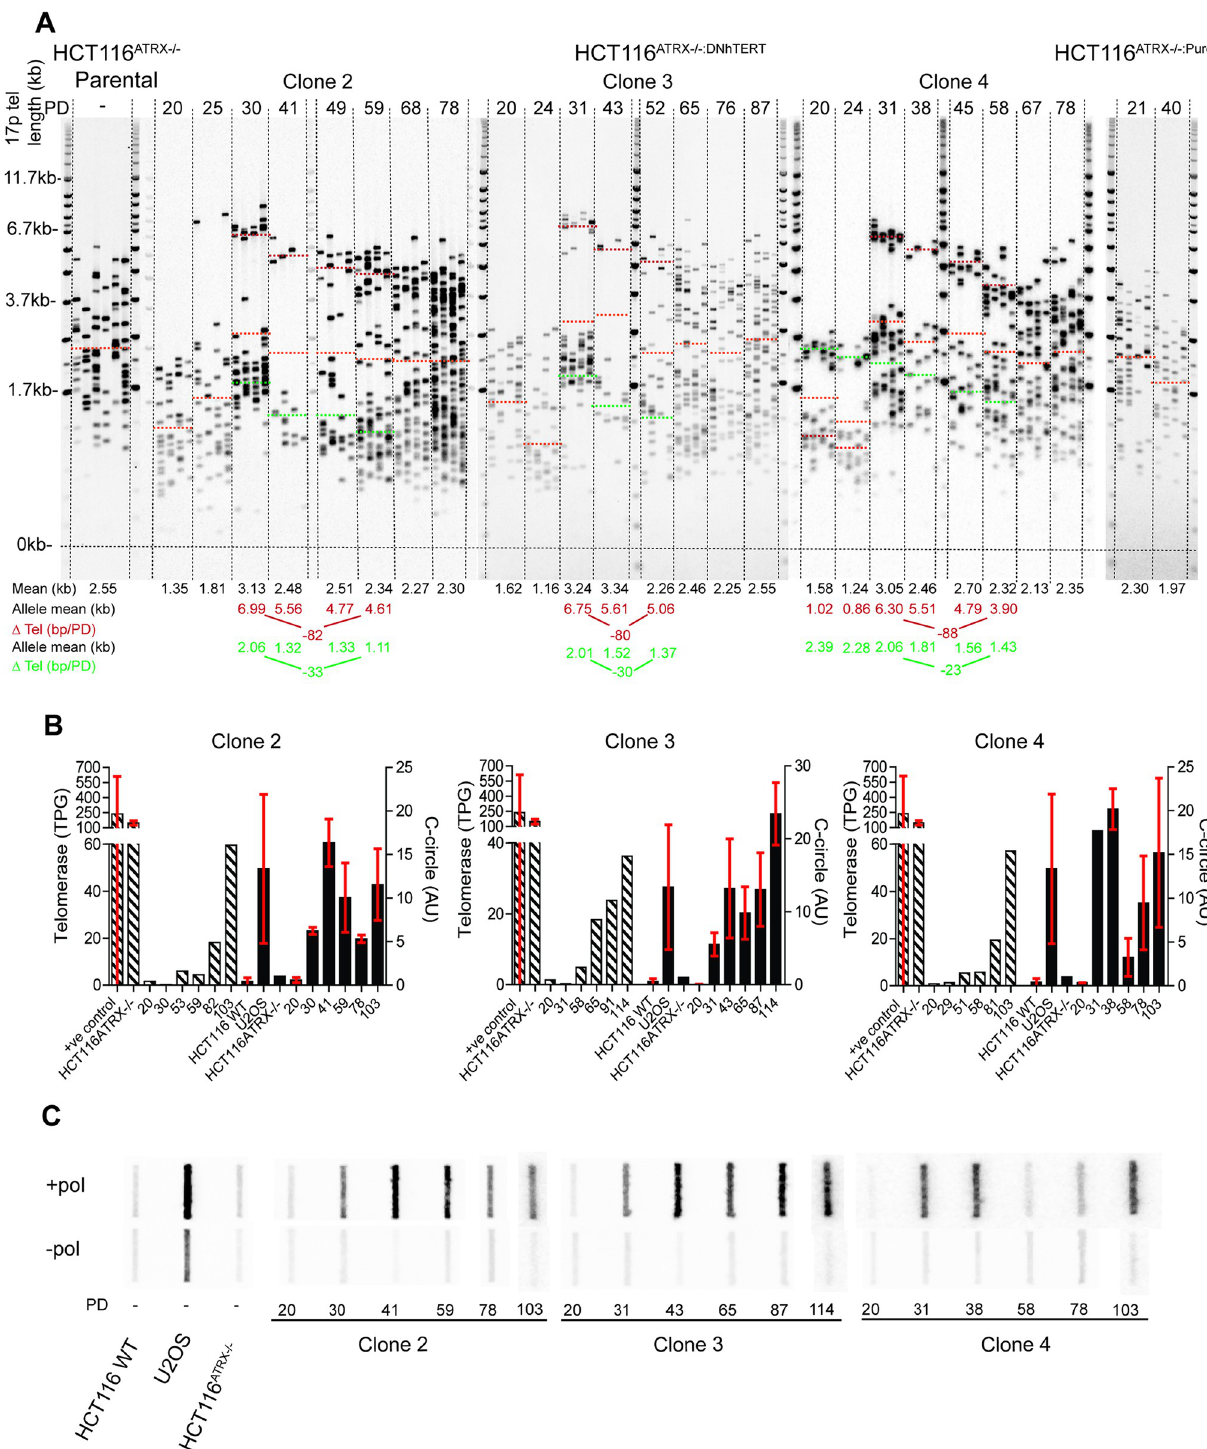
Fig 3. ALT-like telomere elongation and long-term telomerase upregulation in HCT116 epithelial cells. (A) STELA profiles at the 17p chromosome end for the HCT116 ATRX-/o parental; HCT116 ATRX-/o:DN-hTERT ALT-like clones 2, 3 and 4; and HCT116 ATRX-/o:Puro with PD points indicated above and the overall mean telomere length in black (represented as orange dotted lines on the blot) displayed below together with allelic mean telomere lengths (red and green) also represented as dotted lines on the blot. The rate of erosion is represented by Δ Tel and is expressed in bp/PD. (B) Quantification of telomerase activity (expressed in total product generated: TPG) on the left axis and the C-circle intensity (expressed in arbitrary units: AU) on the right